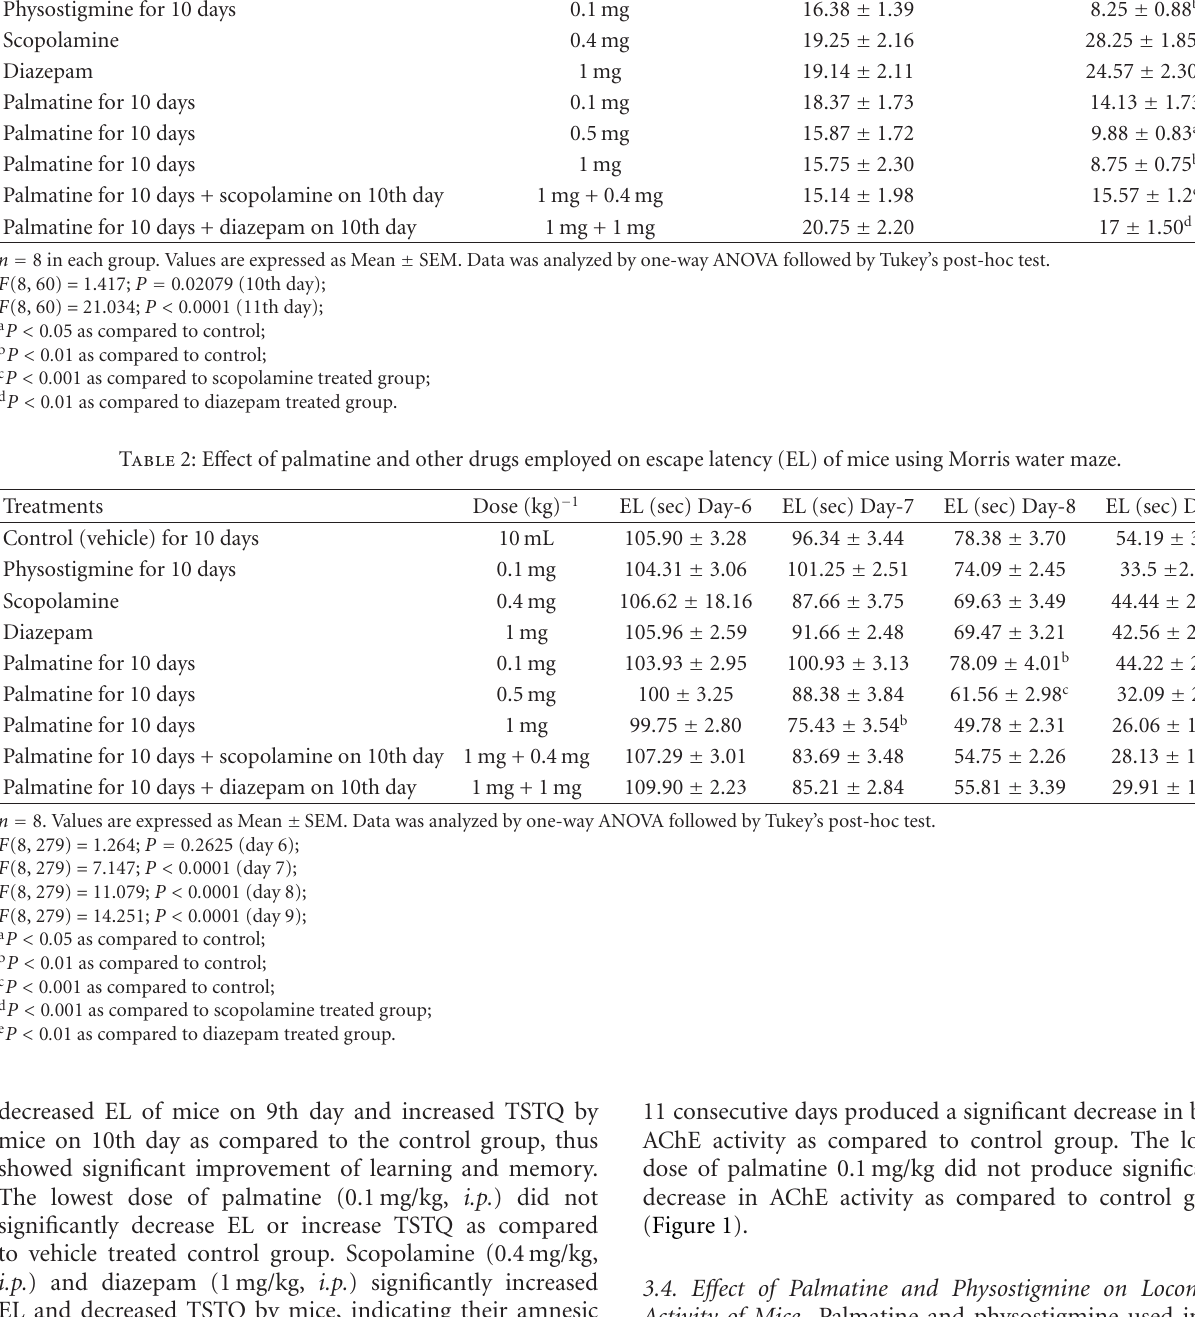
Table 1: E ff ect of palmatine and other drugs employed on transfer latency (TL) of mice using elevated plus maze. Treatments Control (vehicle) for 10 days